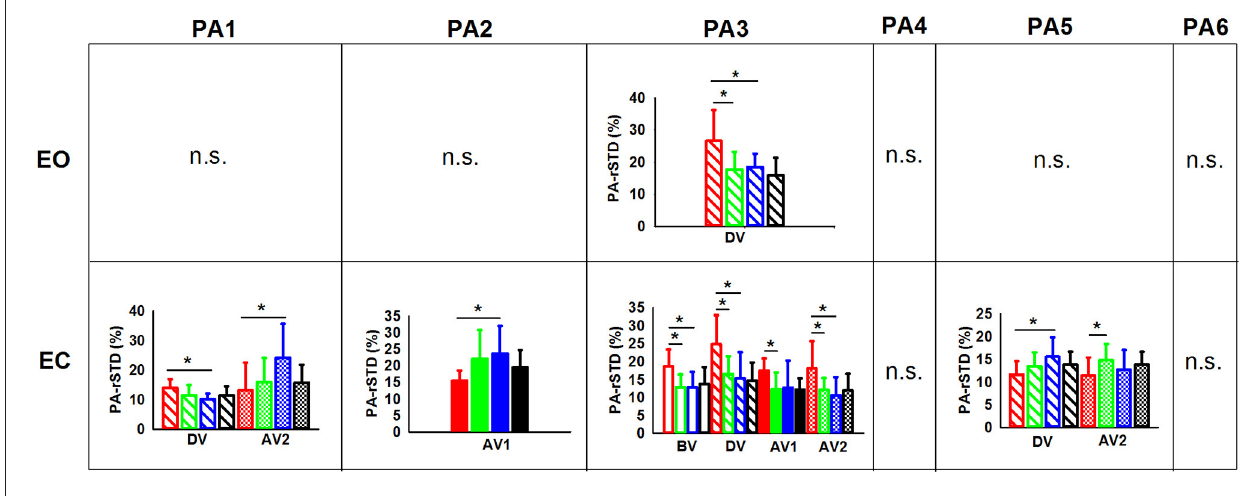
FIGURE 7 | PAs (principal velocities) means and standard deviations for the children [non-gymnasts (C-NG) in red and gymnasts (C-G) in green] and adults [non-gymnasts (A-NG) in blue and gymnasts (A-G) in black] by visual condition (EO, eyes open; EC, eyes closed). Only phases (BV, before vibration; DV, during vibration; AV1, after vibration early phase; AV2, after vibration late phase) with significant differences between groups were plotted, with different shading used for each phase. (*) Indicates significant differences from planned comparisons. (n.s.) Indicates non-significant differences.